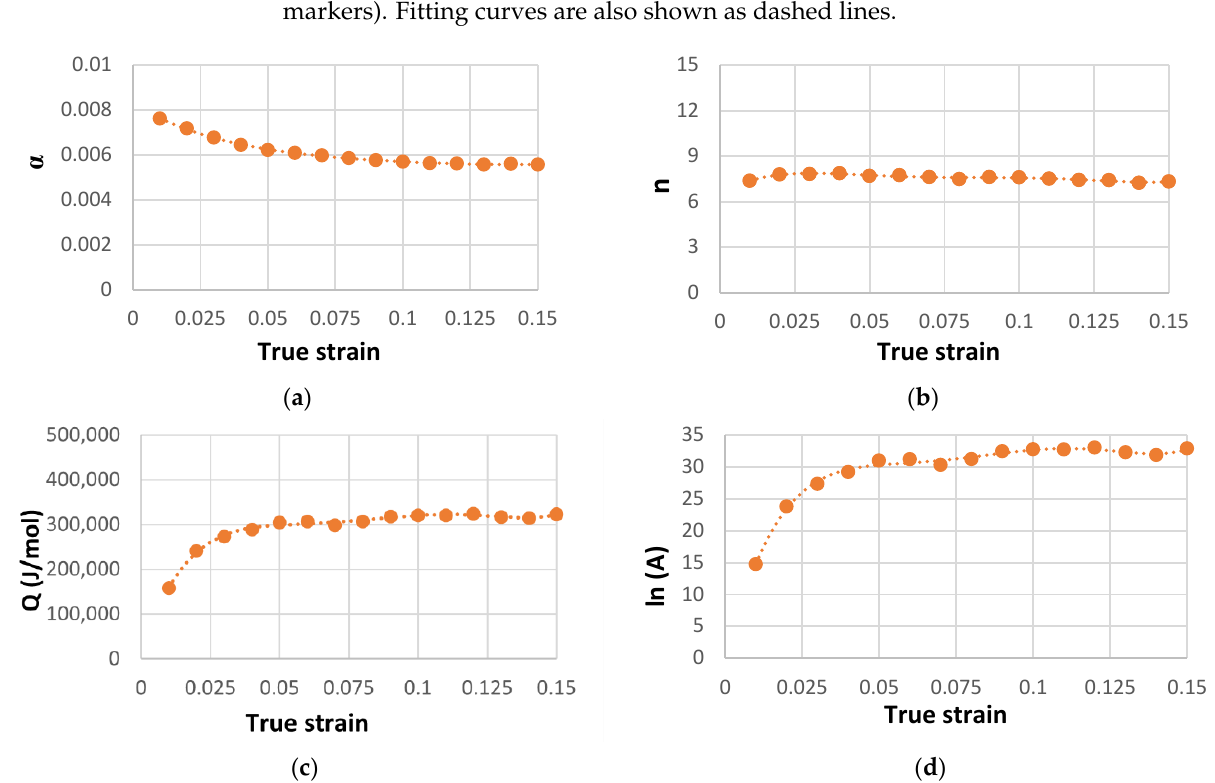
(18) The coefficients of polynomial fitting are listed in Table 3. Table 3. Polynomial coefficient of α, n, Q, ln(A) for USIBOR ® 1500.